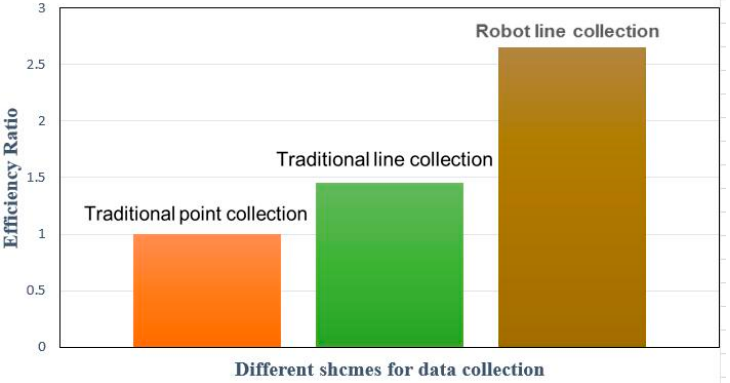
Figure 15. Efficiency ratio results of three schemes.